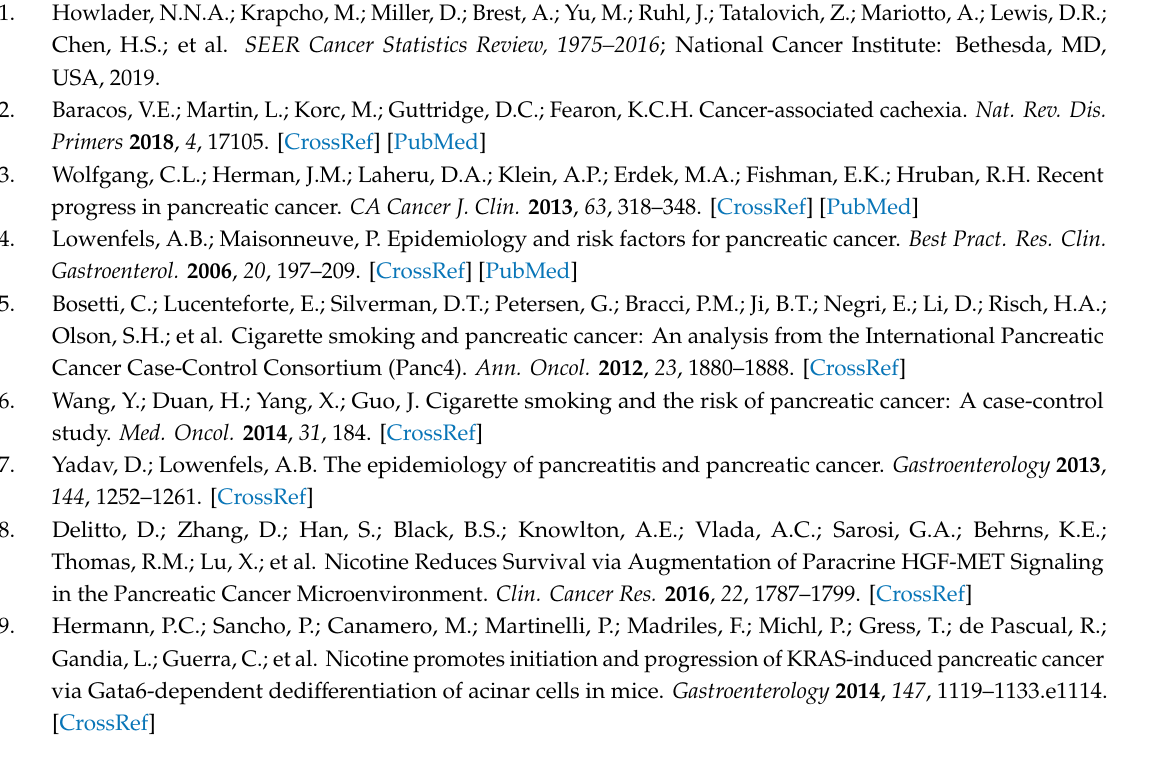
Figure S1: Original western blots, Table S1: Densitometry of each band normalized to